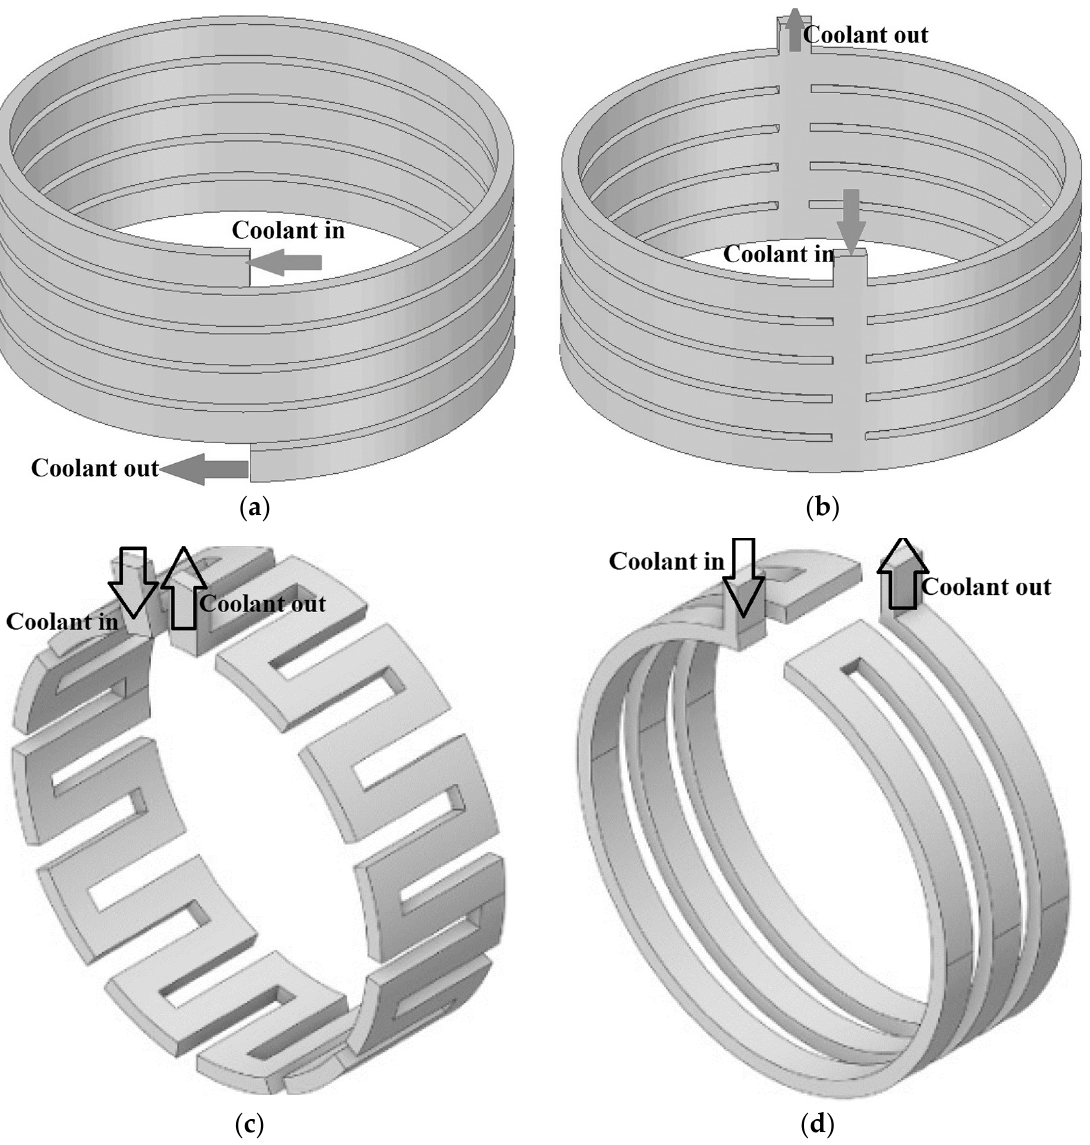
Figure 10. ( a ) Spiral water jacket; ( b ) Bifurcated U-shaped water jacket; ( c ) Axial water jacket; ( d ) Dial water jacket [42,43].